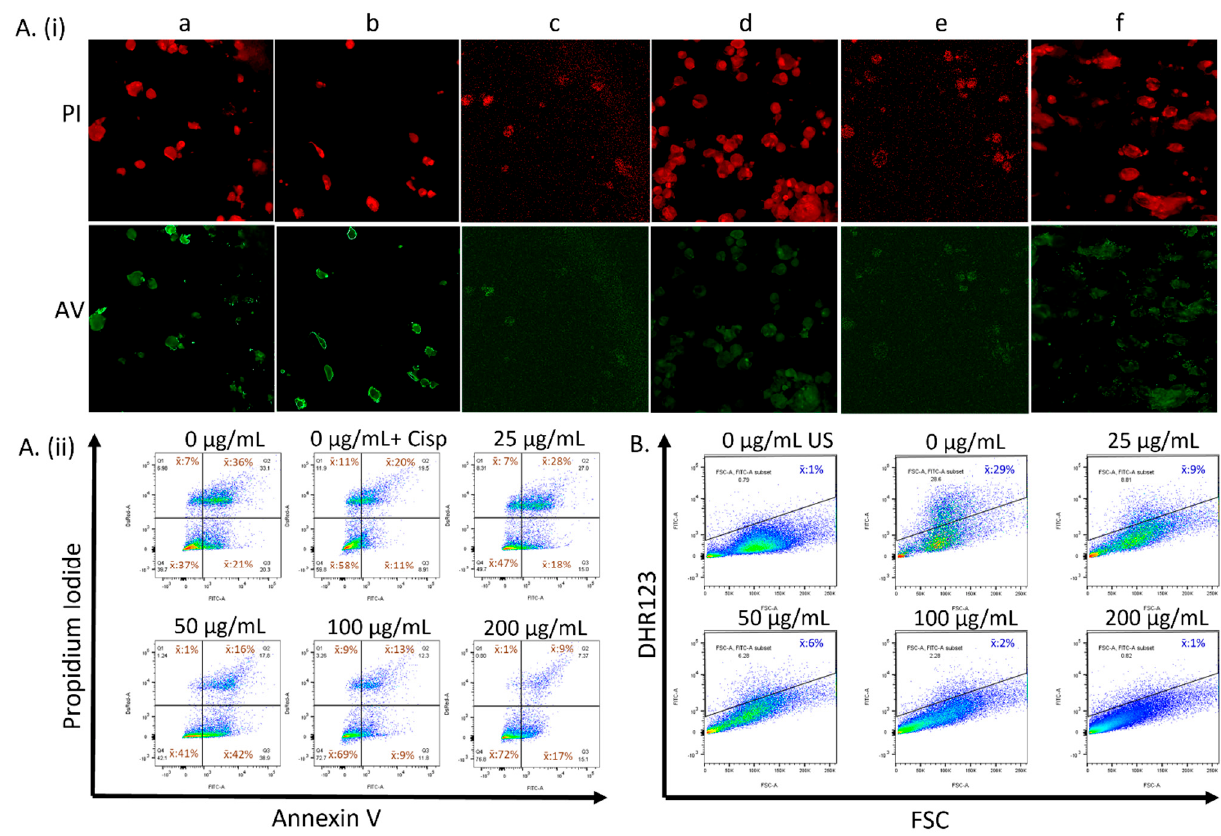
Figure 2. Concentration-dependent modulation of cellular health and reactive oxygen species by CeO 2 nanoparticles in MDA MB231 breast carcinoma cells. ( A ). ( i ) Comparison confocal fluorescence images of cells labeled with propidium iodide (top panel) and Annexin V (bottom panel) following treatment with ( a ) 0, ( b ) 0 + Cisplatin, ( c ) 25, ( d ) 50, ( e ) 100, ( f ) 200 μ g ml − 1 CeO 2 nanoparticles. ( A ). ( ii ) Four-quadrant gating of viable (AV − /PI − ), early apoptotic (AV + /PI − ), apoptotic and necrotic (AV + /PI + ), and already dead (AV − /PI + ) cells not treated or treated with cisplatin, 25, 50, 100, or 200 μ g ml − 1 nanoceria, analyzed for green fluorescence (Annexin V, FL1-A) and red fluorescence (Propidium Iodide, FL2-A). ( B ). Flow cytometric profiles of cells not labeled or labeled with 10 μ M DHR123 following treatment with 0, 25, 50, 100, or 200 μ g ml − 1 nanoceria. Table 1. Flow cytometry gated profiles of viable (AV − /PI − ), early apoptotic (AV + /PI − ), apoptotic and necrotic (AV + /PI + ), and already dead (AV − /PI + ) cells treated with varying concentrations of CeO 2 NP, or Cisplatin.